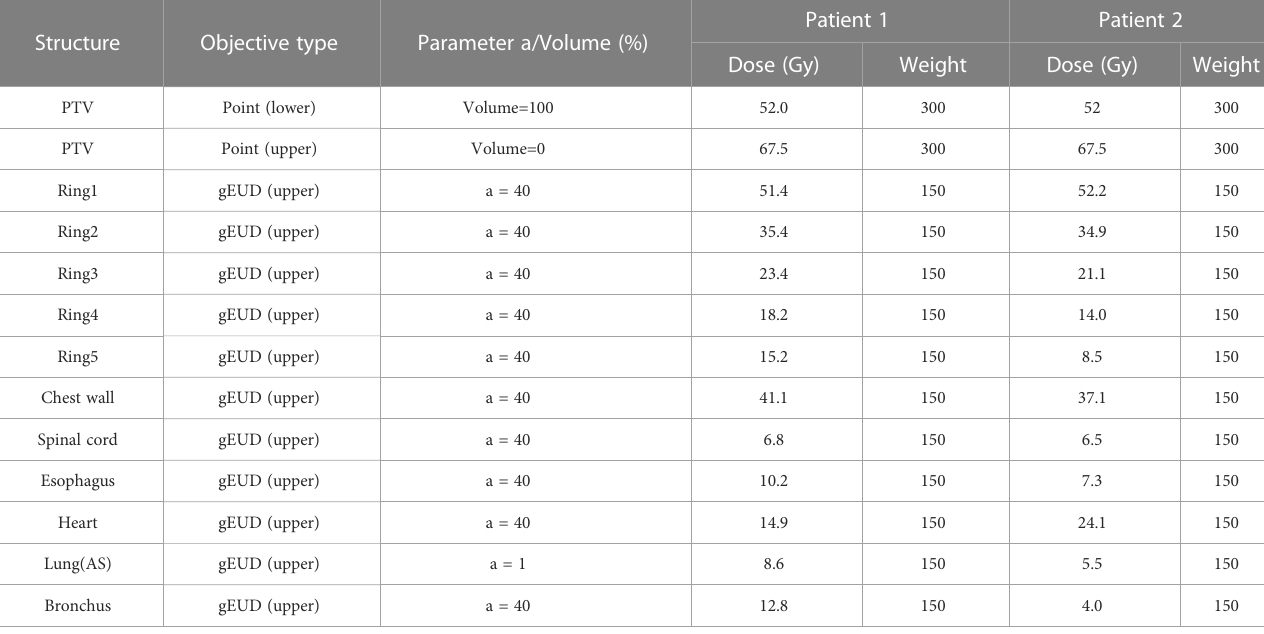
TABLE 2 The initial patient-speci fi c objectives of two representative cases based on the 3D dose prediction module.